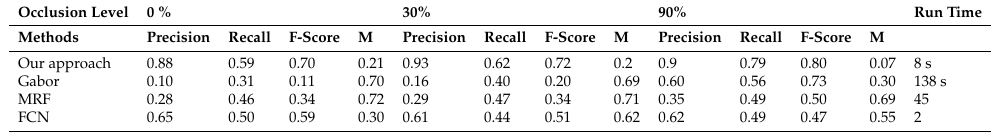
Table 1. Table of the results using binary classification on our dataset. The evaluation was done over three classes of occlusion densities: 0, 30 and 90 %. The metrics are calculated for all three classes Precision, Recall, F-score, and Miss-classification represented as